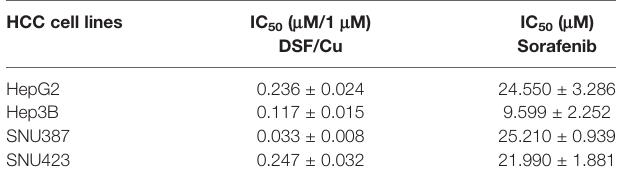
TABLE 1 | IC 50 of sorafenib and DSF/Cu in HCC cell lines in vitro . Data are shown as mean ± SD (n=3). HCC cell